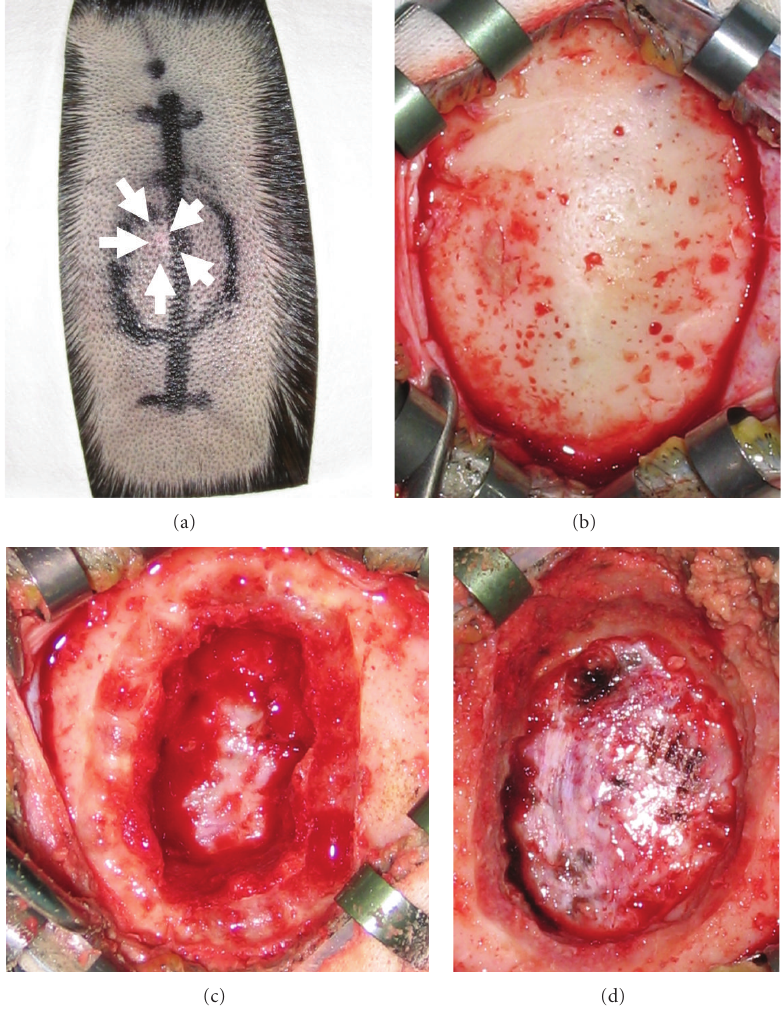
Figure 2: Intraoperative photographs (a–d). Photograph of the skin immediately above the skull mass (a) showing the cutaneous scar (arrowheads) from the past injury. The skull surface just below the skin scar was smooth but swollen (b). Photograph obtained after piercing the cyst (c) demonstrating bloody cyst fluid and the inner surface of the cyst wall with no obvious tumorous change. Intact dura mater was observed after total removal of the skull mass